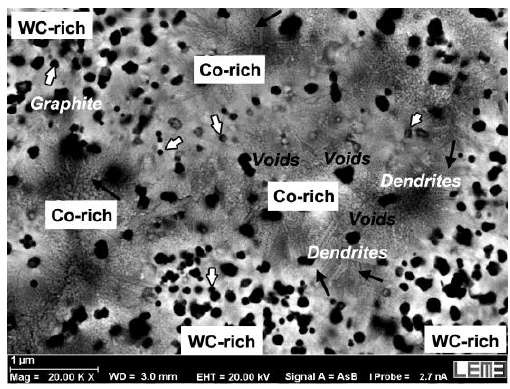
Figure 9. SEM morphology of a 20-pulse-HCPEB treated sample, where the black arrows indicate the dendrites growing from the WC-rich areas while the white ones indicate the formations of graphite.